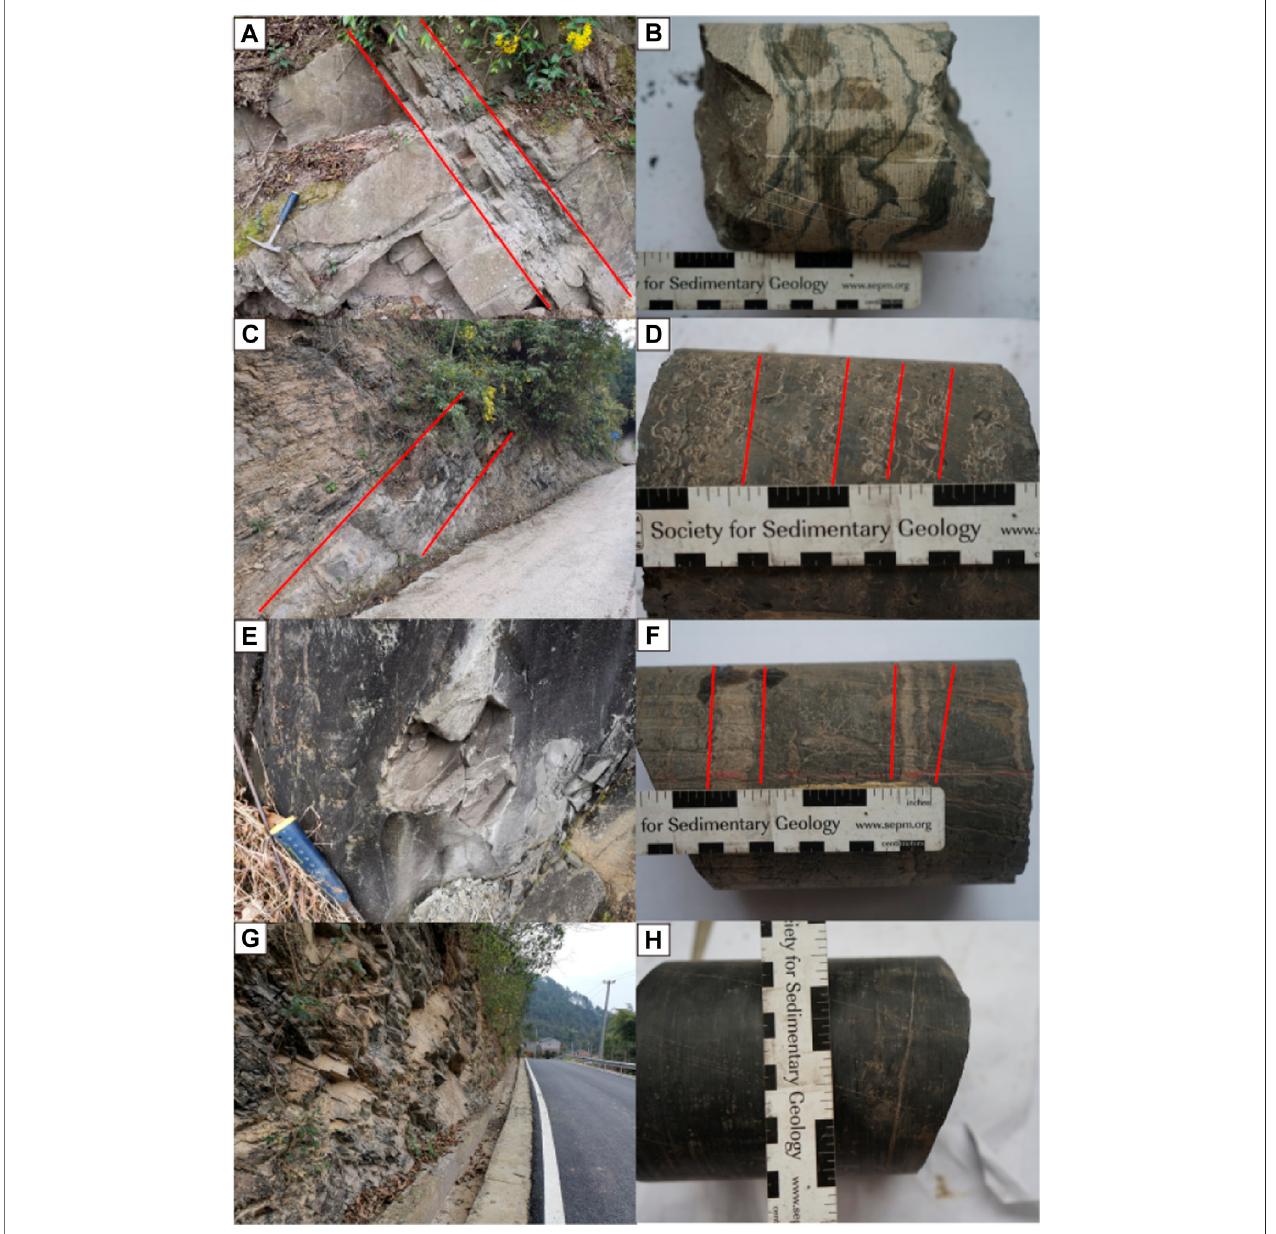
FIGURE 3 | Selected outcrop and drilling core photographs to show the characteristics of sedimentary subfacies in the Dongyuemiao member. (A) Medium- to thick-bedded, dark-gray sandstone from shore lake, the bottom of the outcrop LJ. (B) Light gray-green sandstone from shore lake, the well KJ5 (drilling cores). (C) Medium- to thick-bedded, gray sandstone from shallow lake, the bottom of the outcrop GM. (D) Gray mudstone contains shell debris from shallow lake, the well LP1 (drilling cores). (E) Gray siltstone from the semi-deep lake, the bottom of the outcrop XJ. (F) Gray mudstone interlayered shell debris from semi-deep lake, the well KJ3 (drilling cores). (G) Medium- to thick-bedded, gray siltstone and fi ne sandstone with some thin layers of gray-black shale from deep lake, the bottom of the outcrop ZF. (H) Black-gray shale from deep lake, the well LP8 (drilling cores). Please see Figure 1B for outcrop and well locations.